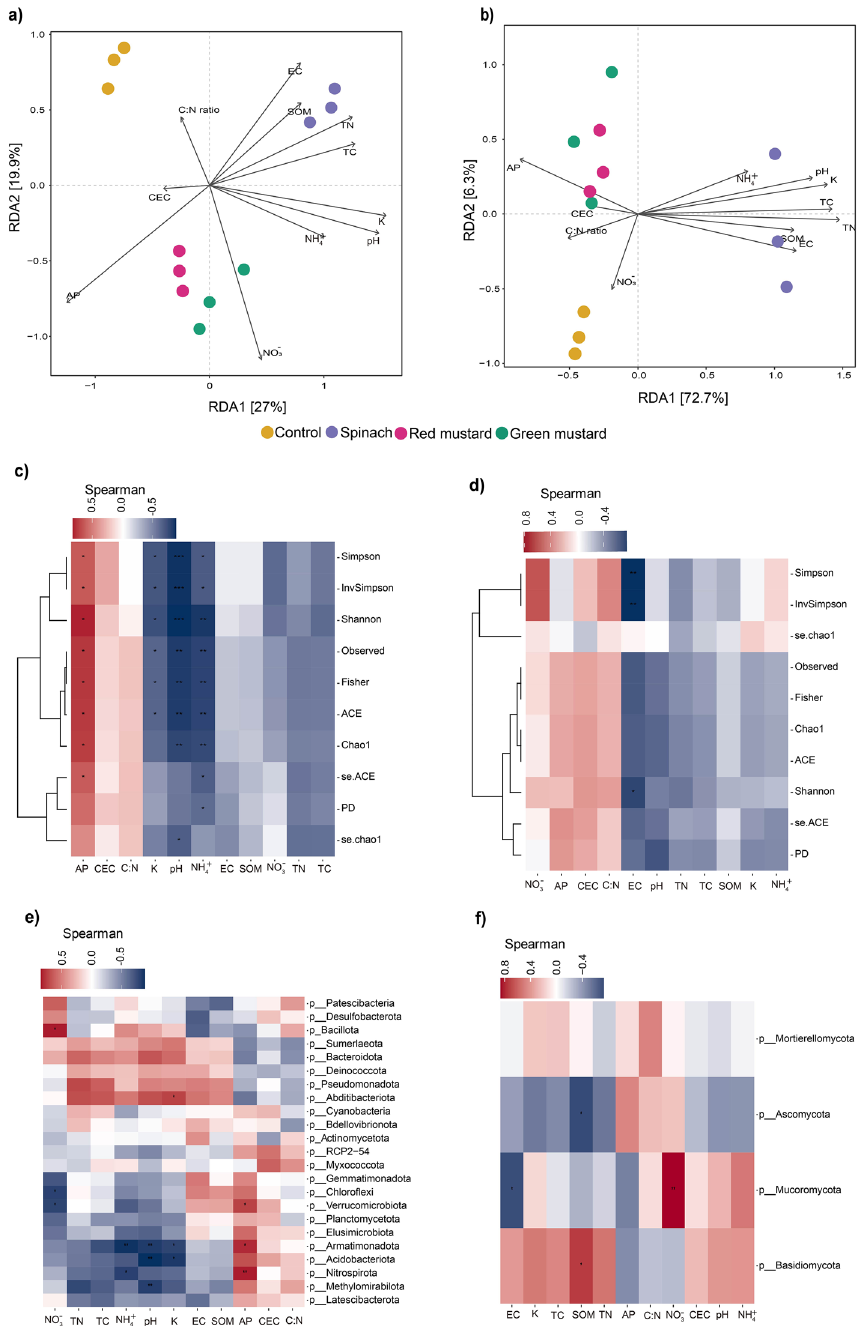
Figure 3. Distance-based redundancy analysis (dbRDA) exhibiting the relationship between soil chemical properties and microbial communities of green manure treatments based on Bray–Curtis distance similarities: bacteria ( a ) and fungi ( b ). The contribution of each soil chemical properties to the soil microbial community structure variation was indicated by the length of arrows. Spearman correlation between soil chemical properties with alpha diversity indices and phylum relative abundance of bacteria ( c , e ) and fungi ( d , f ). Refer Table 1 for the abbreviation of soil chemical